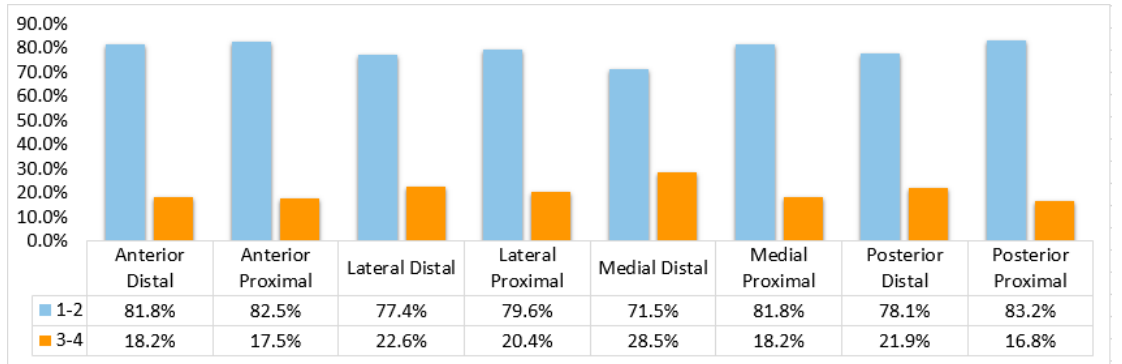
Figure 3. The quantity of the double score levels at each zone (scores 1 and 2 versus scores 3 and 4 combined).